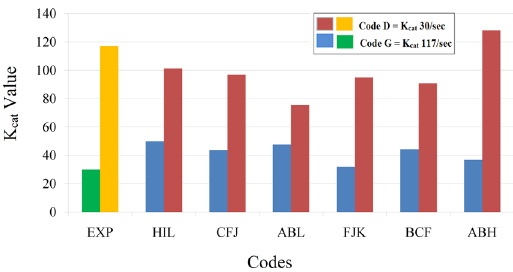
Figure 4. Graph of experimental vs. predicted activity of the validation sets of the models derived from 6188 IEDs chosen based on the r value >